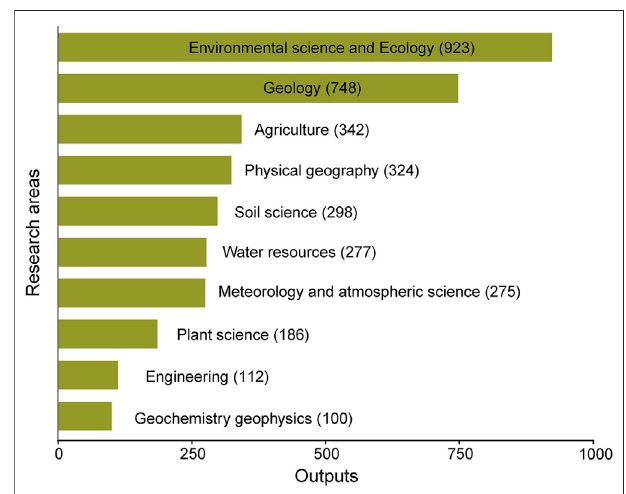
FIGURE 4 | The 10 most productive areas of the research on deserts in China. The output numbers are listed in parentheses.